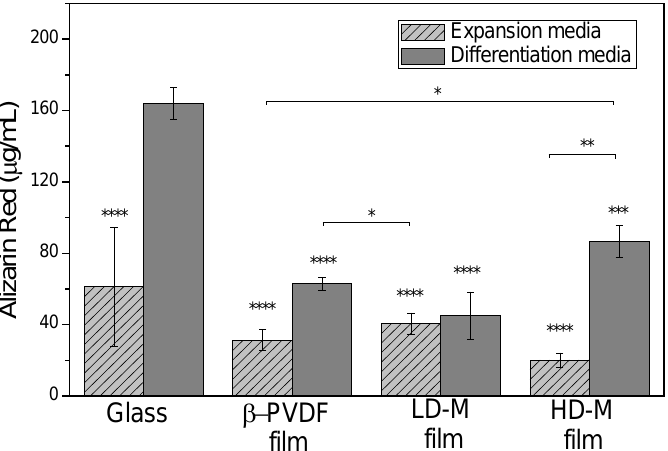
Figure 7. Alizarin red staining (ARS) acid extraction in hMSCs cultured in different substrates with osteogenic supplements (differentiation media) and without them (expansion media) after 14 days. Data are expressed as the mean ± standard deviation with n = 3. * p ≤ 0.05, ** p < 0.01, *** p ≤ 0.001 vs. Glass with differentiation media and **** p ≤ 0.0001 vs. glass with differentiation media.